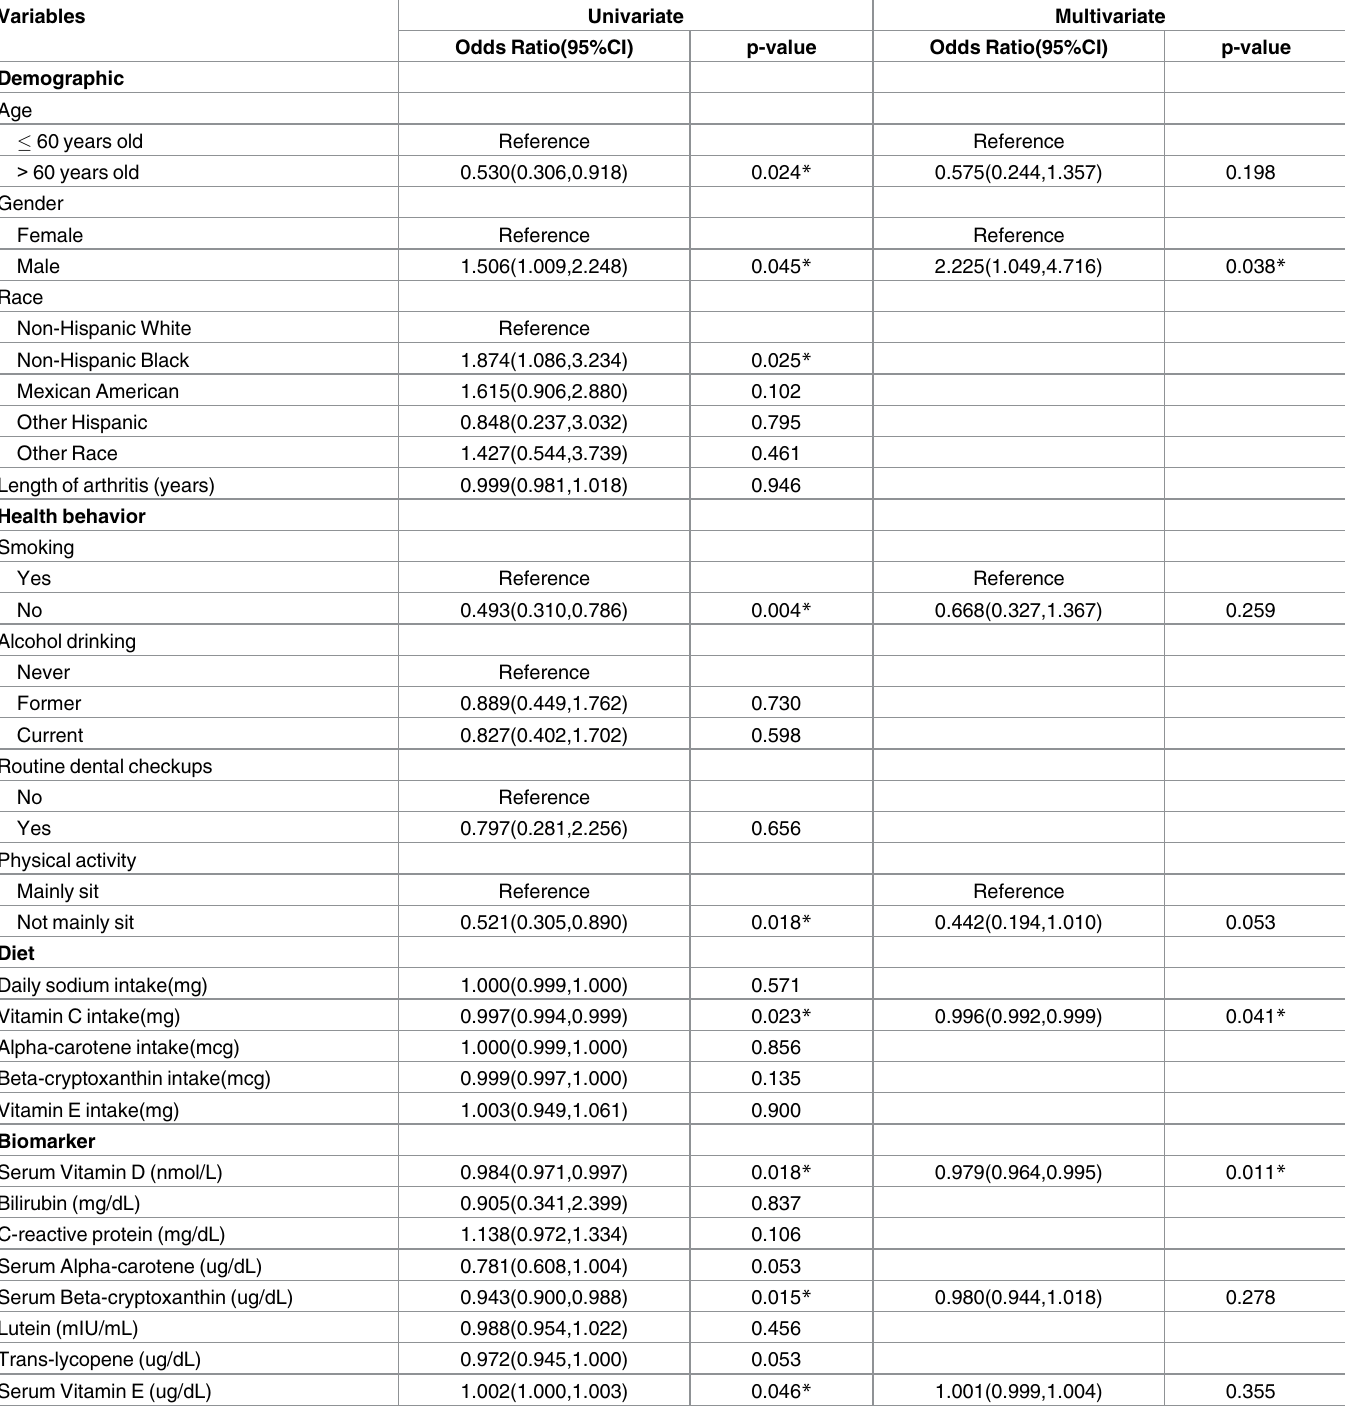
Table 2. Logistic regression analysis of protective factors associatedwith the risk of gingival